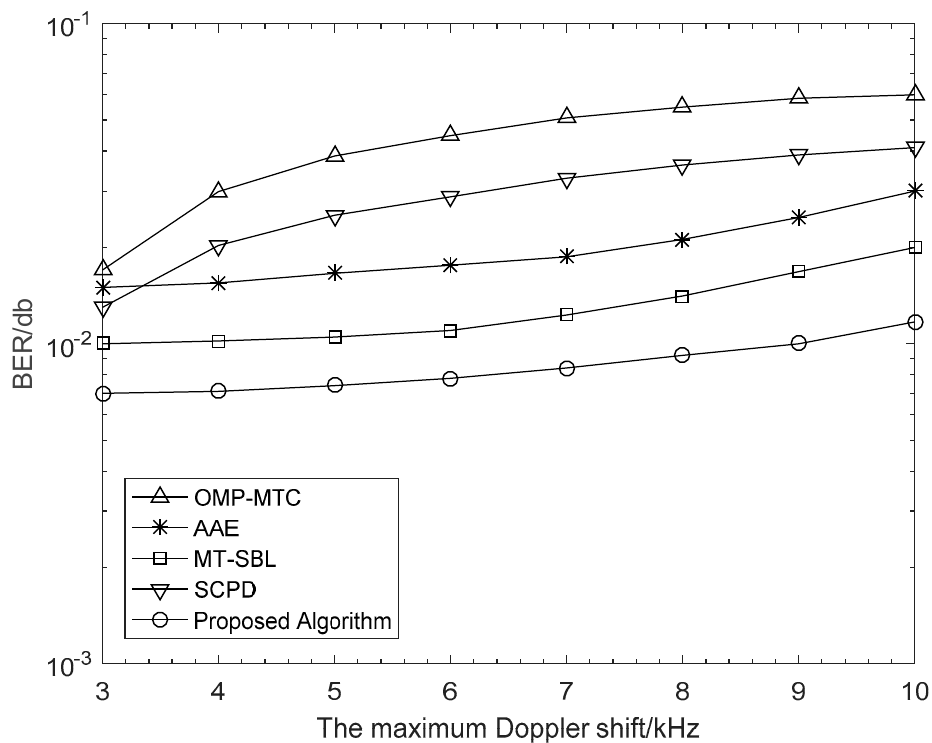
Figure 5. BER performance against the maximum Doppler shift with G T = 128, G R = 32, SNR = 20 dB, N R = 16, and N T = 64 antennas. The number of vehicles is 4, and the distance between vehicles is greater than 50 m.